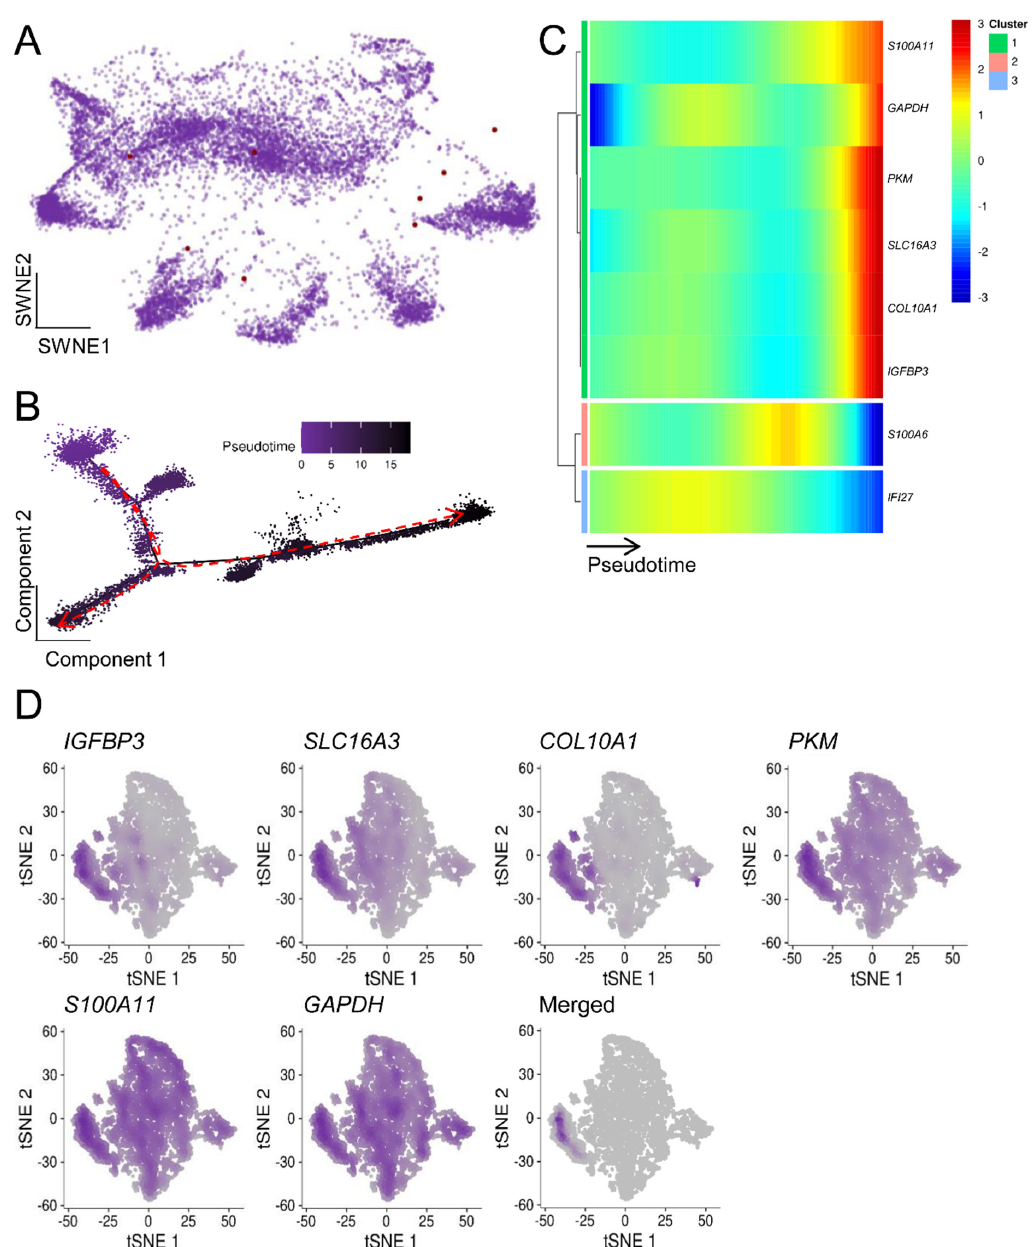
Figure 7. The heterogeneity of PDAC complicated defining the role of ASIGs. ( A ) In total, 24 PDAC samples (PRJCA001063 [53]) were weighted in an SWNE graph based on 8 previously defined ASIGs induced in PDAC (depicted as red dots). ( B ) The pseudotime development of malignant PDAC cells from early (left, purple) to late (right, black) stages indicated the presence of three distinct cell fates. ( C ) S100A11, GAPDH, PKM, SLC16A3, COL10A1, and IGFBP3 were significantly upregulated over time. ( D ) Cells expressing these markers form a distinct subpopulation as depicted in a t-SNE.